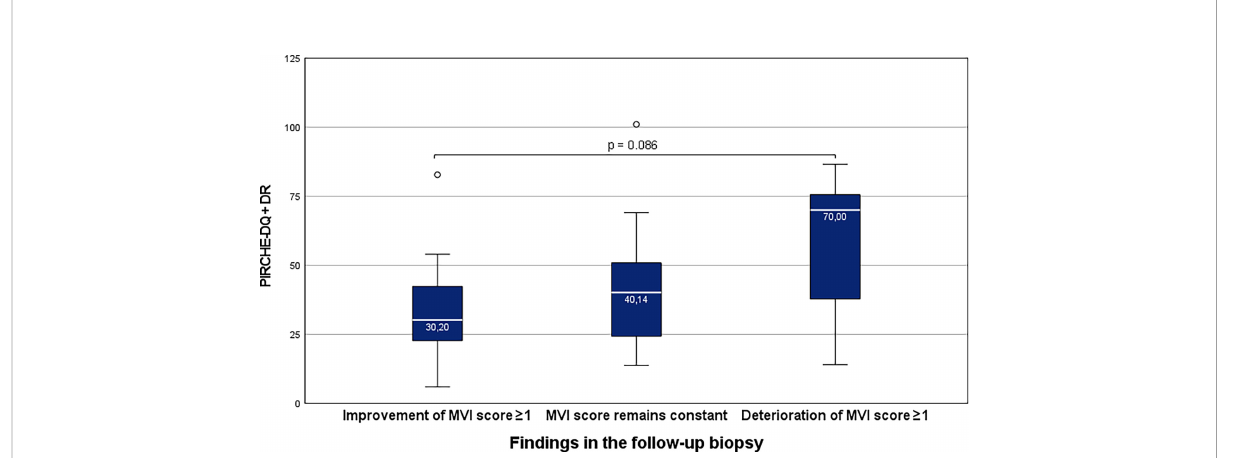
FIGURE 5 Higher total PIRCHE-II scores for the HLA-DQ and -DR loci mismatches among KTRs with ABMR, who show an increase in the MVI-score in the follow-up biopsy. Boxplots show median, interquartile range (IQR), and 95 th